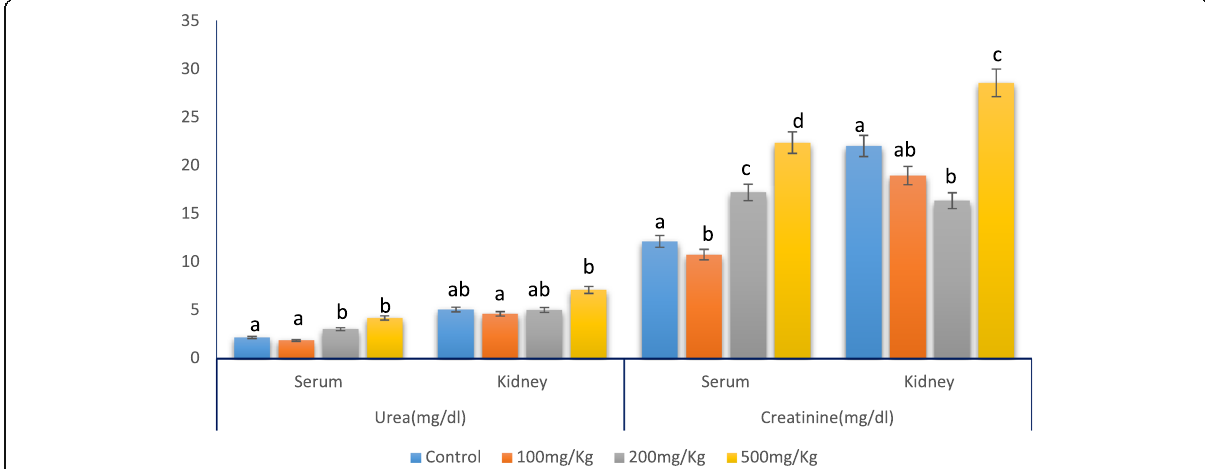
Fig. 5 Effect of Dennettia tripetala methanol extract on levels of serum and renal Urea/Creatinine Nitrogen